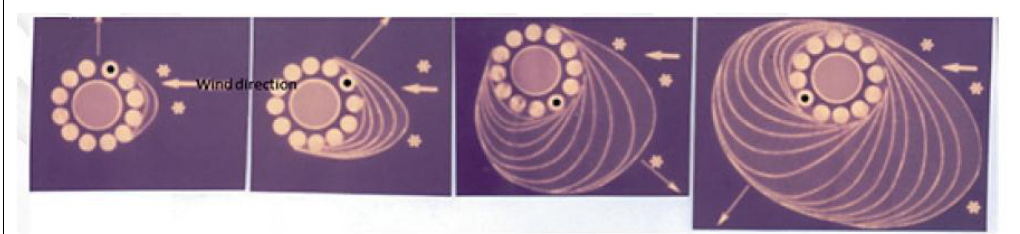
Figure 4. Cylindrical ice sleeve accretion on conductors during a wet snowfall.